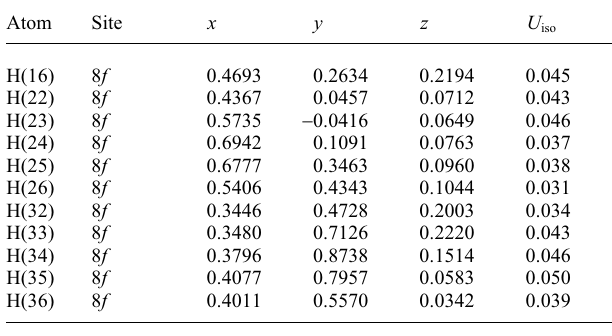
Table 3. Atomic coordinates and displacement parameters (in Å 2 )